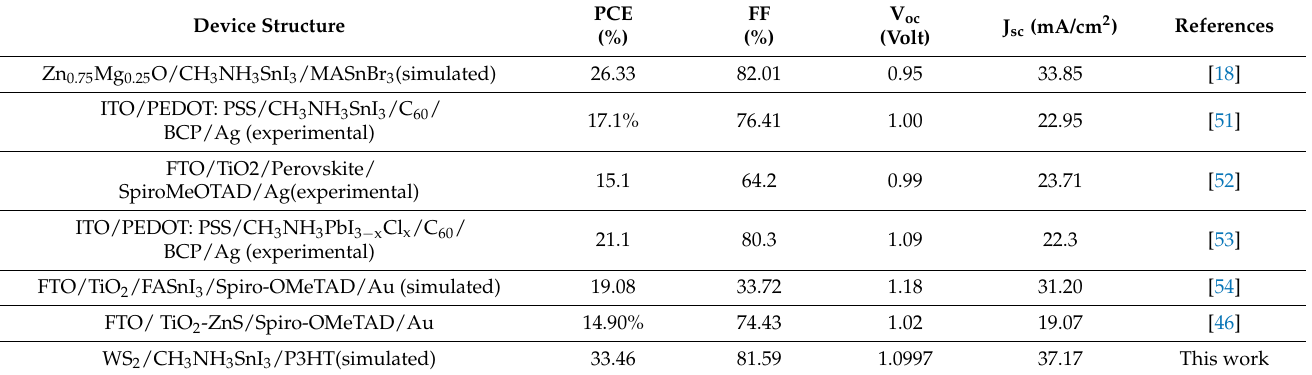
Table 2. Comparison with the finding of the simulated and experimentally reported results. Device